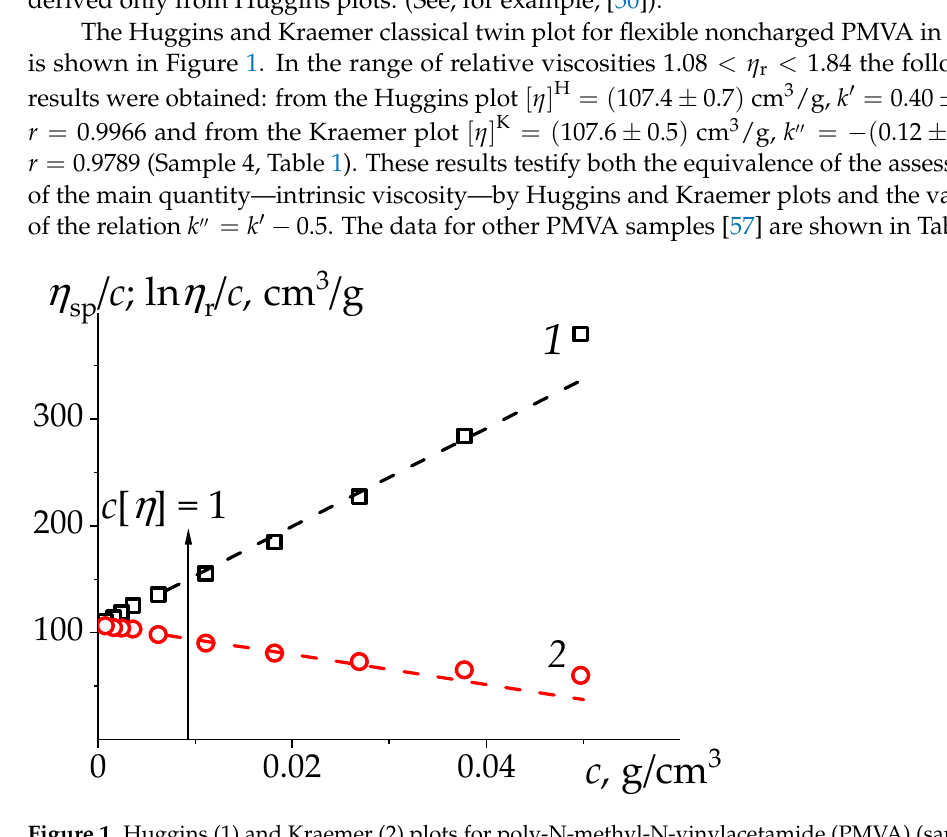
Figure 1. Huggins (1) and Kraemer (2) plots for poly-N-methyl-N-vinylacetamide (PMVA) (sample 4 in Table 1) in H 2 O at 25 °C. The values of intrinsic viscosity, Huggins and Kraemer parameters were determined in the interval of relative viscosity: 1.08 < 𝜂 (cid:2928) < 1.84 by extrapolation to 𝑐 → 0 . Dashed lines are drawn over the entire range of concentrations and relative viscosities 1.08 < 𝜂 (cid:2928) < 19.86 . Table 1. The molecular masses 𝑀 (cid:2929)(cid:2888) , the values of intrinsic viscosities obtained from Huggins ( [𝜂] (cid:2892) ) and Kraemer ( [𝜂] (cid:2895) ) plots and Huggins ( 𝑘 (cid:4593) ) and Kraemer ( 𝑘 (cid:4593)(cid:4593) ) parameters for PMVA in H 2 O at 25 ° С .